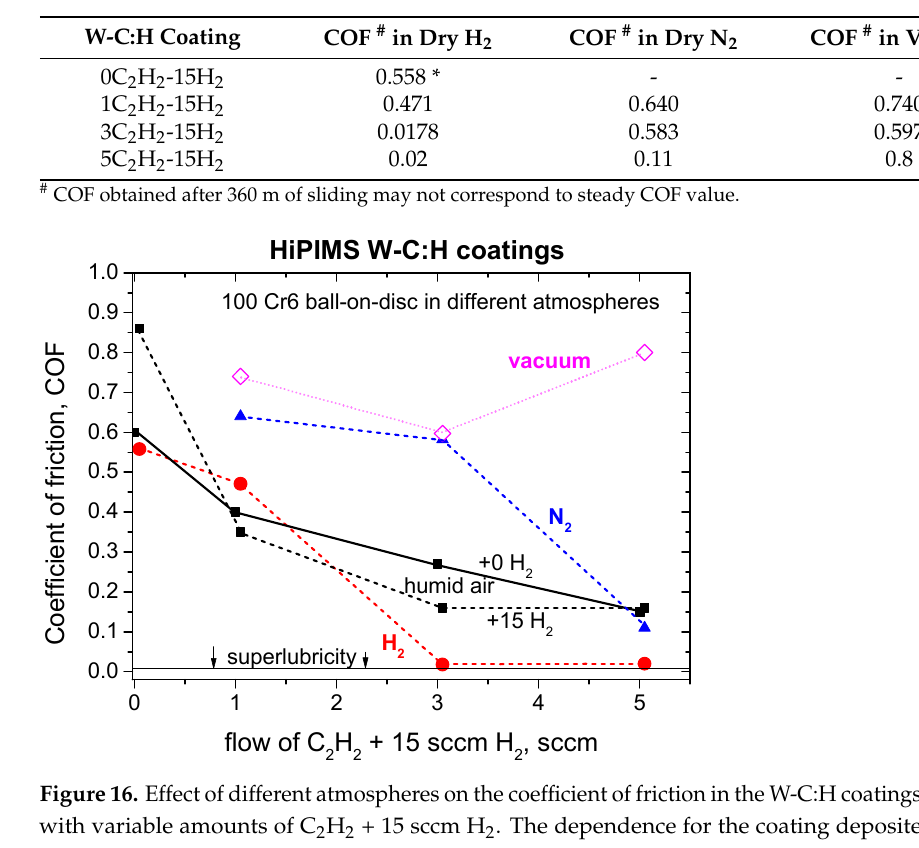
Table 3. Summary of the influence of atmosphere on the coefficients of friction of W-C:H coatings deposited with different additions of acetylene and hydrogen in the sputtering atmosphere. The data were obtained under the load of 0.5 N (*0.25 N) at the sliding speed of 0.1 m/s.